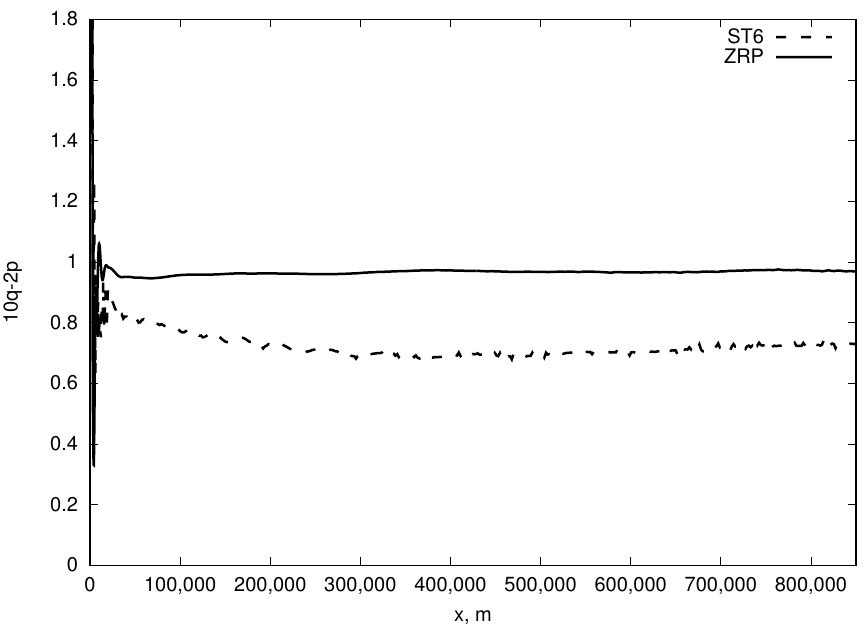
Figure 5. Magic number 10 q − 2 p as the function of the dimensionless fetch. Figure 6 shows 3D wave energy spectrum for the fetch x = 21 km as the function of frequency f and angle θ , localized in the angular spread of (cid:39) 60 ◦ around the spectral maximum frequency for the ST6 case described by Equation (2).